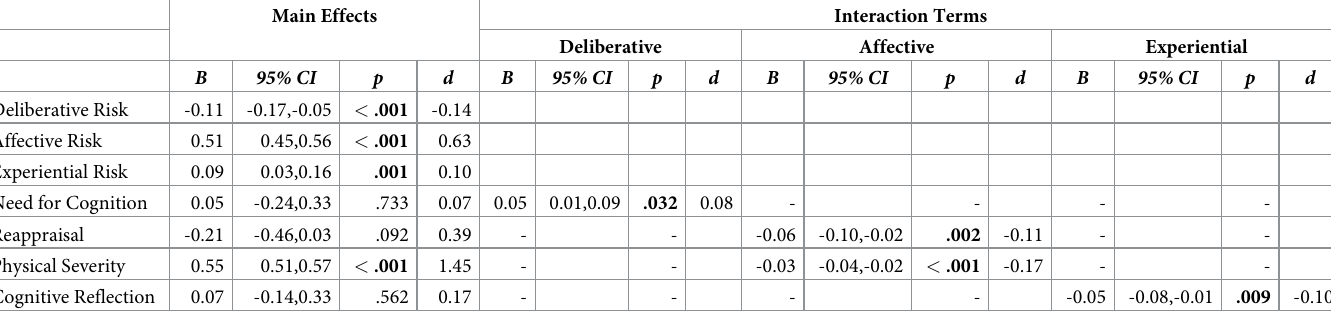
Table 4. Main effects and interactions among three risk perceptions, health threat characteristics, and individual differences ( n of observations =